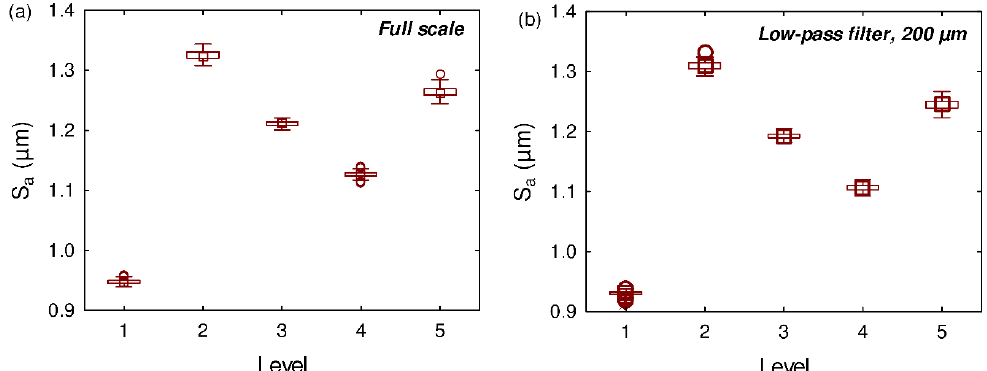
Figure 2. ( a ) Full scale arithmetical mean height S a values as a function of the visual roping levels, after tensile testing, ( b ) Arithmetical mean height S a values obtained with a low-pass filter and a cut-off of 200 µm as a function of the visual roping levels, after tensile testing.